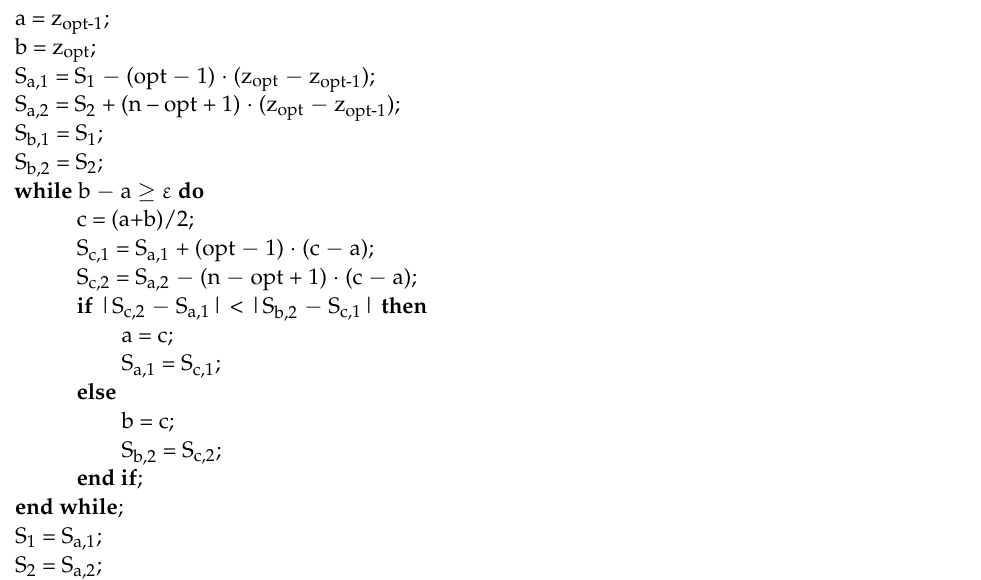
Algorithm 6 Divide and conquer for optimum excavation/filling plane